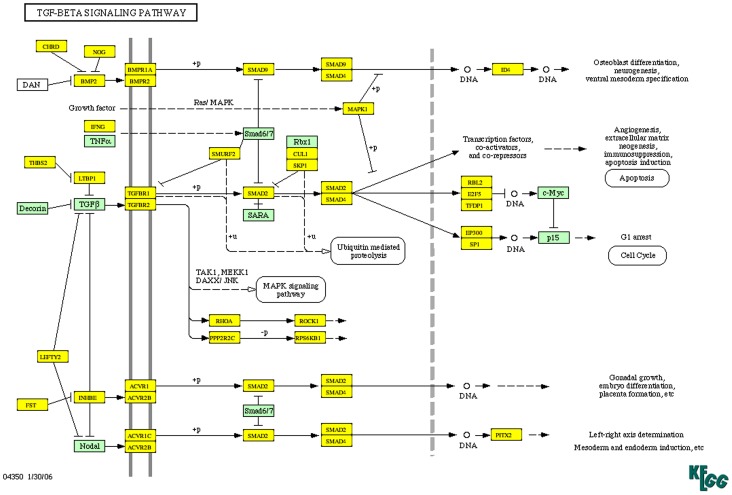
TGF-β signaling pathway.Genes highlighted in yellow are predicted targets of miR differentially regulated in N v TSI (35 miR) (FC>3 p<0.05). Genes highlighted in green are not predicted targets.